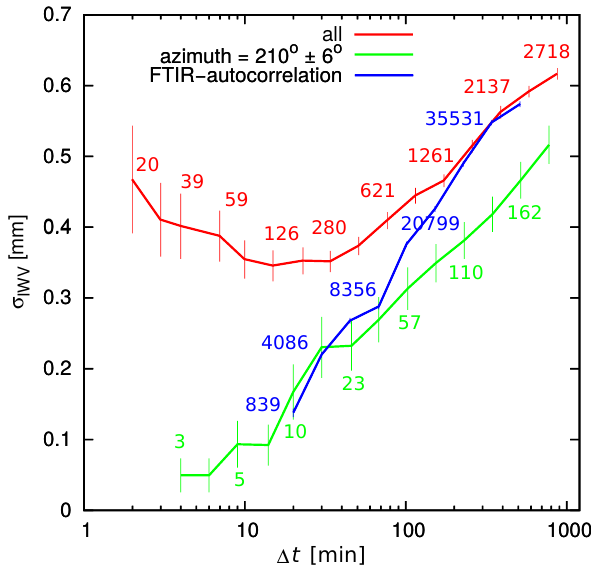
Figure 5. Variability as a function of the length of the time interval. The red curve shows σ IWV from all measurements with no geo- metrical restrictions as a function of the length of the time interval in which data were taken into account. The green curve only in- cludes measurements recorded in the early afternoon when the vol- ume matching peaks with a sun azimuth of 210 ± 6 ◦ . The blue curve only shows σ IWV of IWV values from the FTIR instrument. The quantity of measurement pairs from which σ IWV was calculated is indicated by the numbers near the curves (not for all nodes). The uncertainties ( ± σ ) are indicated by the error bars (for calculation see